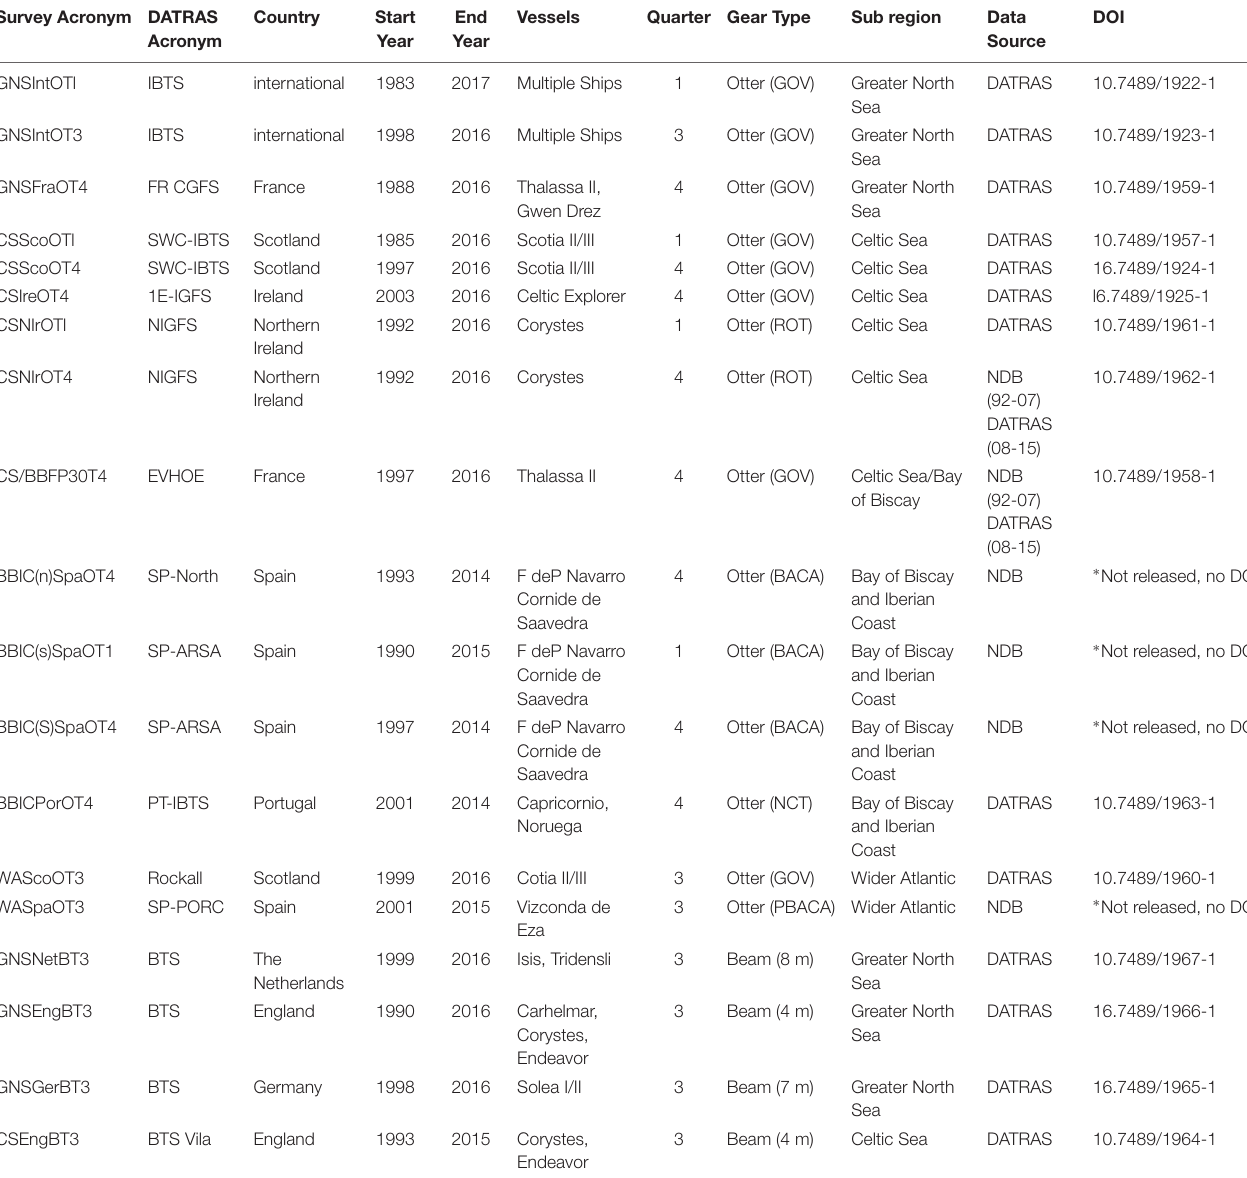
TABLE 1 | List of individual surveys considered in the derivation of the OSPAR Groundfish Survey Monitoring and Assessment data products. Survey Acronym DATRAS